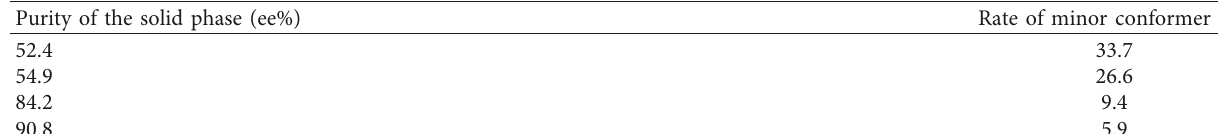
Table 1: Decreasing rate of minor conformer in the solid